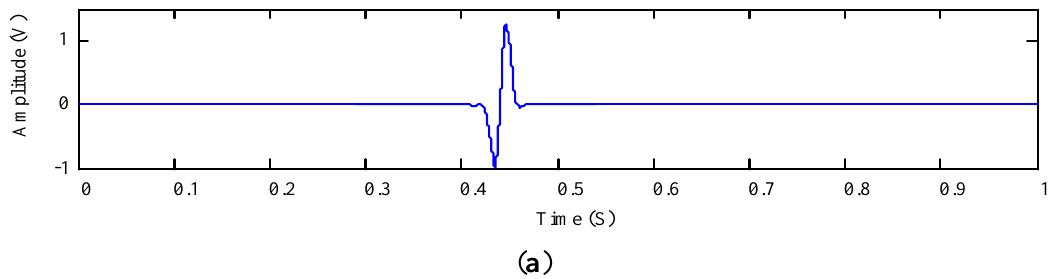
Figure 12. Extraction of the 508 μm aluminum particle signature using the proposed approach: ( a ) extracted particle signature; and ( b ) residue